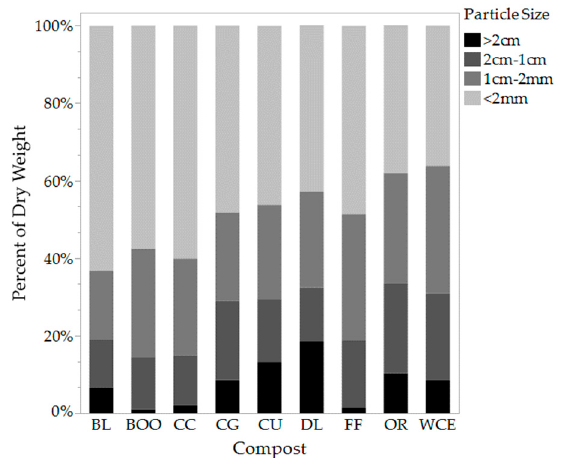
Figure 1. Composition of the compost particle size (>2 cm, 2 cm–1 cm, 1 cm–2 mm, <2 mm) by dry weight.